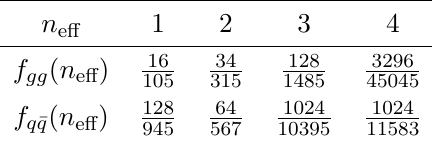
Table 4 . The coefficients that appear in eq. (A.8) for gluon-gluon and quark-antiquark collisions as a function of the effective power-law dependence, n mass squared.